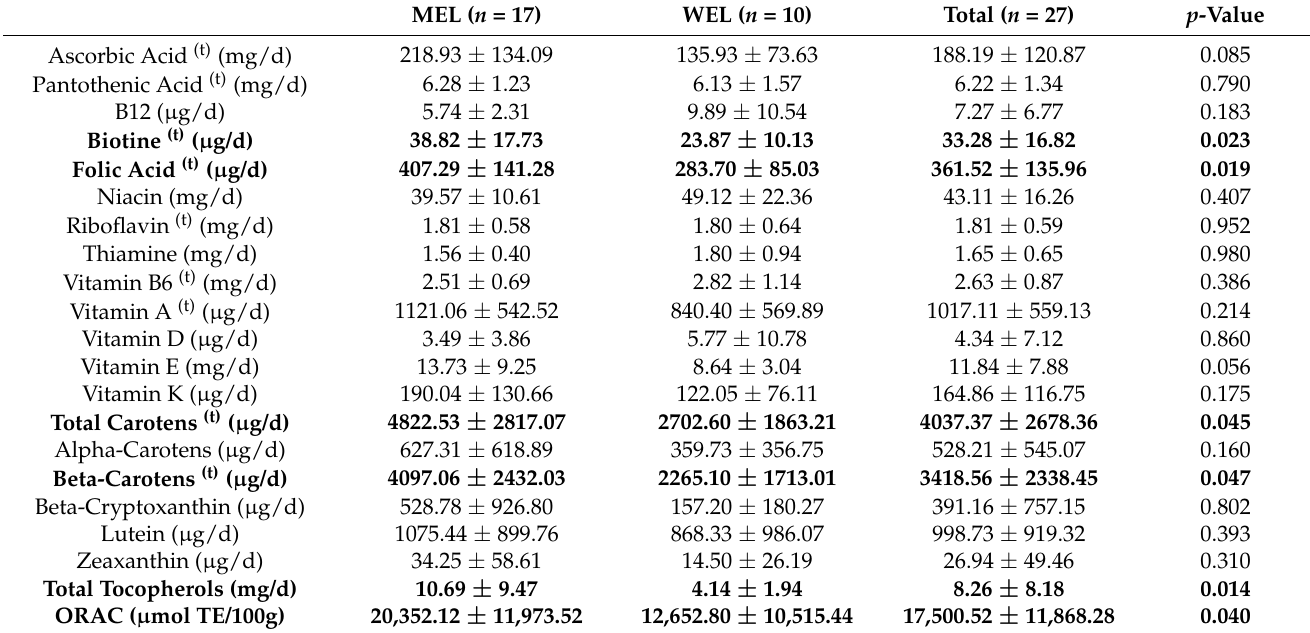
Table A3. Vitamins y antioxidants.